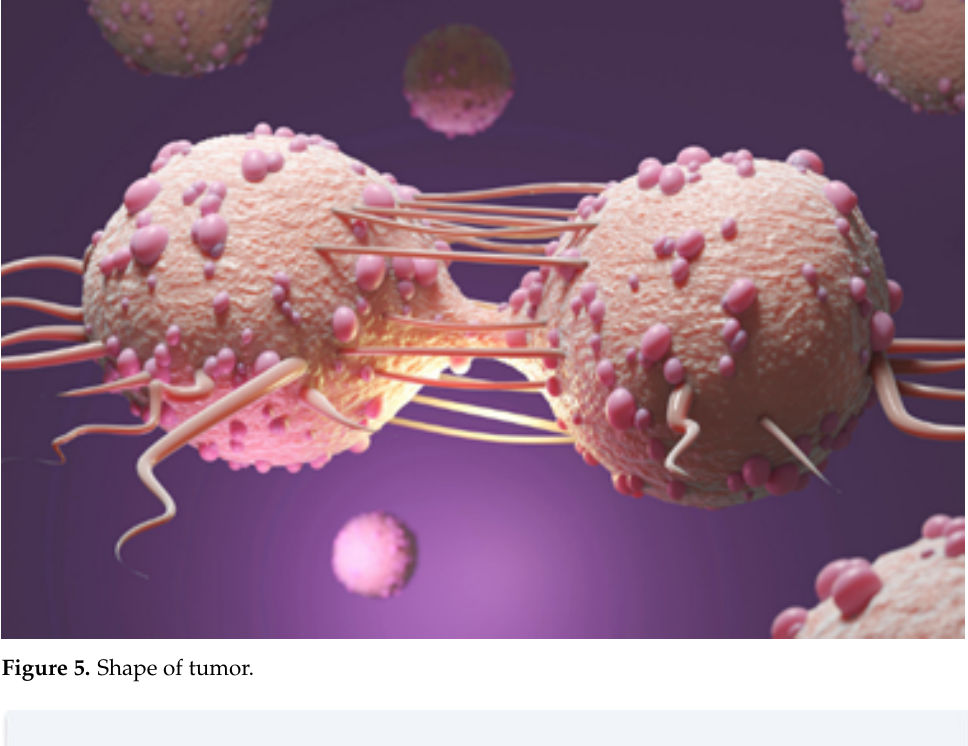
Figure 5. Shape of tumor.